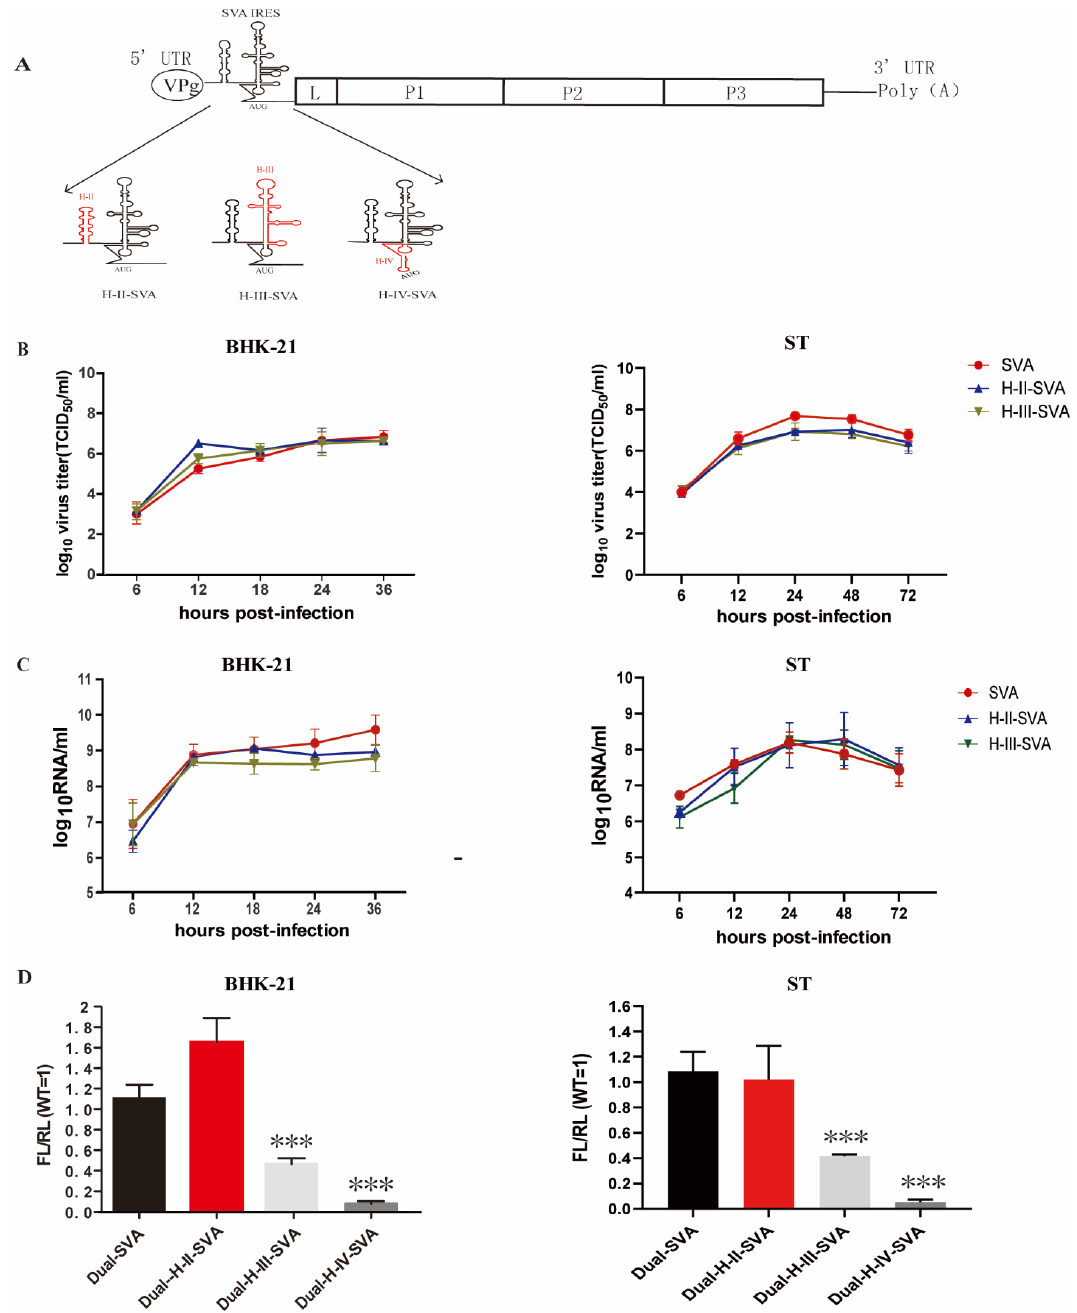
Figure 2. IRES activity and replicating ability of the domain specific IRES-chimeric SVA. ( A ) The schematic diagram for the construction of the IRES-chimeric SVA. The top black graph depicts SVA genome. The SVA IRES is indicated by arrows. The domain specific mutants used in this analysis are shown. The red sequences indicate replacement with HCV IRES counterparts. ( B )BHK-21 and ST cells were infected with SVA or IRES-chimeric SVA viruses at an MOI of 0.01. Growth curves were determined by TCID 50 assay. ( C )The viral RNA levels of SVA or IRES-chimeric SVA were determined by RT-qPCR. ( D ) IRES activities of WT SVA and IRES-chimeric SVA; BHK-21 and ST cells were transfected with the dual-luciferase reporter plasmids of Dual-H-II-SVA, Dual-H-III-SVA, Dual-H-IV-SVA or Dual-SVA. At 12 h post-transfection, the RLuc and FLuc activities in the cell lysates were quantified. The results are presented as the means+SD from at least three independent experiments. Significance of the changes were analyzed by Student’s t -test and indicated by *** p <